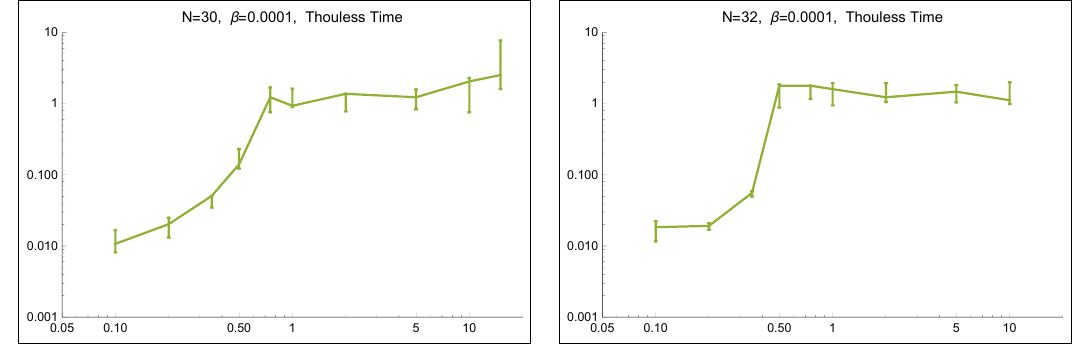
Figure 16 . Thouless time as a function of (cid:20) , for N = 30 ; 32 and (cid:12) = 10 (cid:0) 4